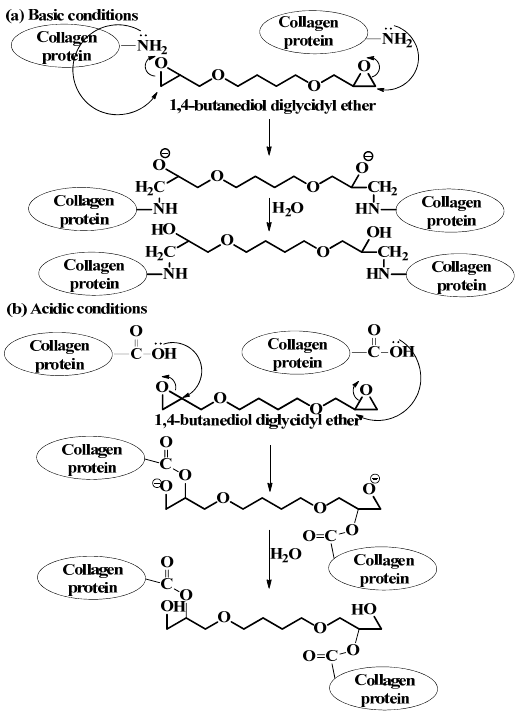
Figure 7. Reactions showing 1,4 ‐ butanediol diglycidyl (BDDGE) ether mediated crosslinking of collagen proteins under ( a ) basic and ( b ) acidic conditions. ( a ) In basic conditions, nucleophilic attack occurs at the less substituted alkane of epoxide BDDGE with the amine group of a lysine residue in collagen, ( b ) In acidic conditions, nucleophilic attack occurs at the more substituted alkane of epoxide BDDGE with the carboxyl group of aspartate/glutamate residues in collagen.